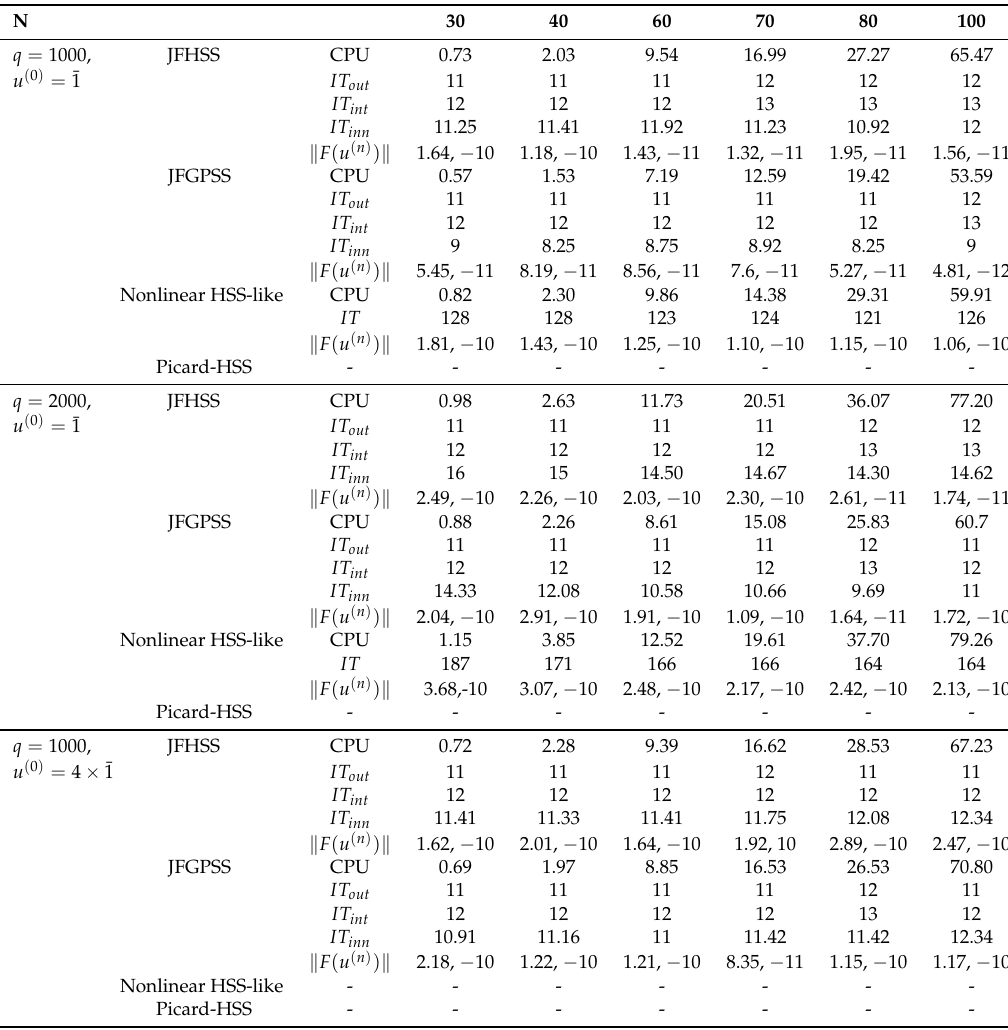
Table 2. Results for JFHSS, JFGPSS, nonlinear HSS-like and Picard-HSS methods of Example 1, Case 2 ( η = tol =